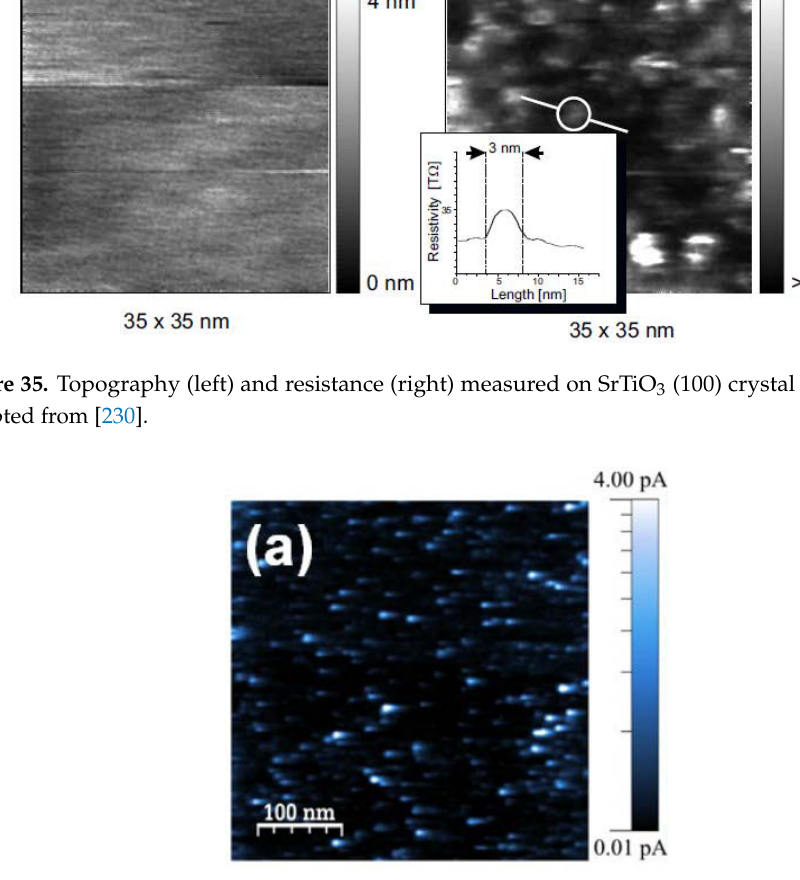
Figure 36. LCAFM image of 500 nm × 500 nm of a ‘pristine’ TiO 2 (110) surface recorded at 20 V. Adapted from